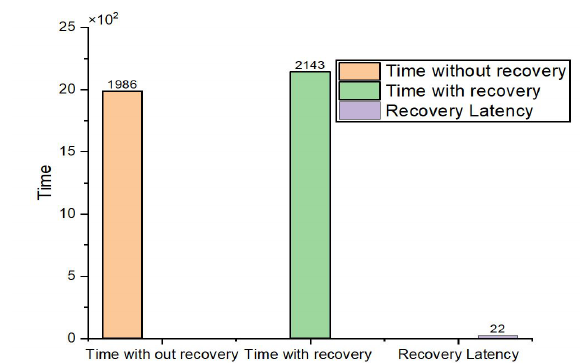
Figure 11. Results: pattern C.